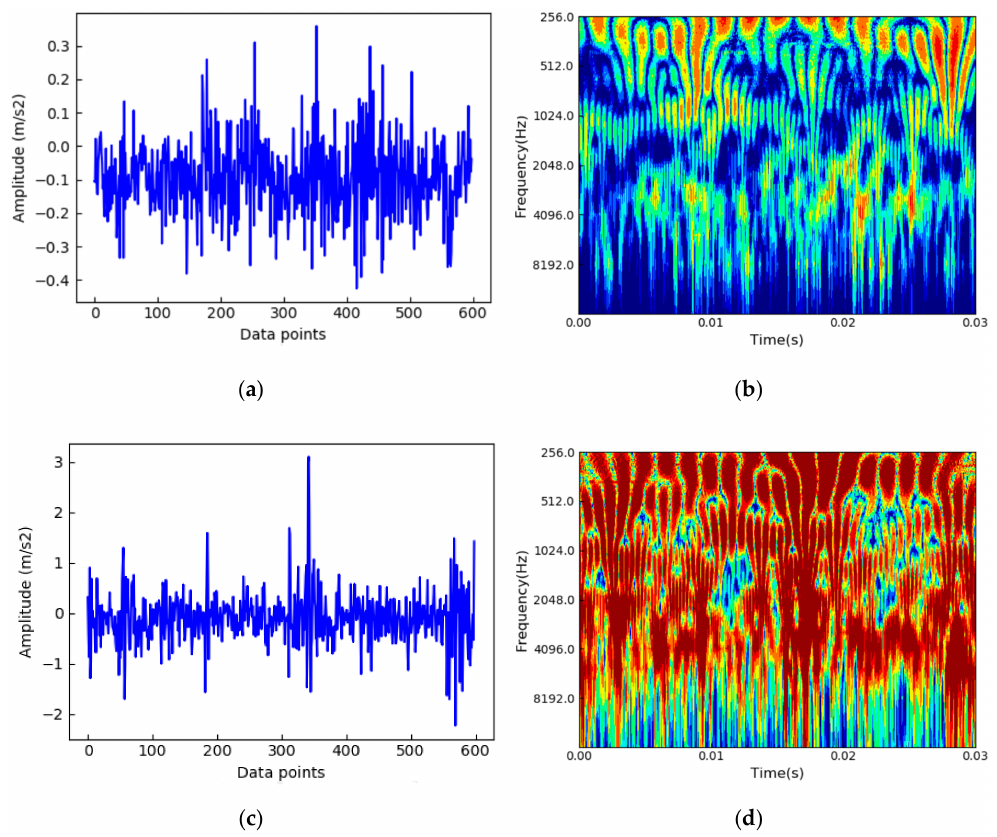
Figure 7. Comparison of time-domain vibration signals and power spectrum images for healthy and damaged signals: ( a ) raw signal (normal stage) [45], ( b ) wavelet power spectrum (normal stage), ( c ) raw signal (failure stage) [45], and ( d ) wavelet power spectrum (failure